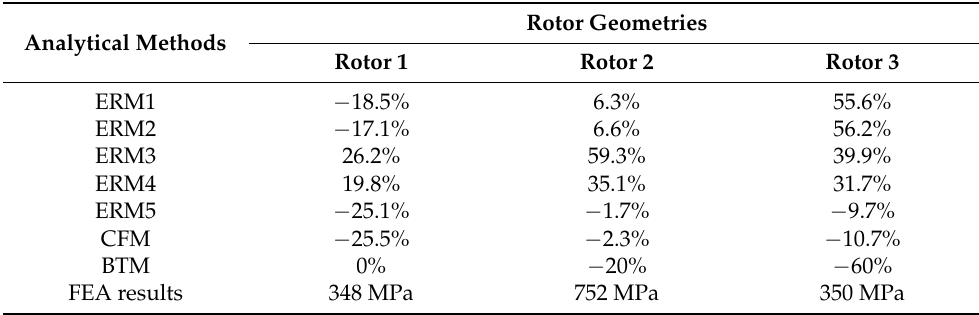
Table 3. Evaluation of analytical methods to determine the maximum mechanical stress at the air gap bridges.